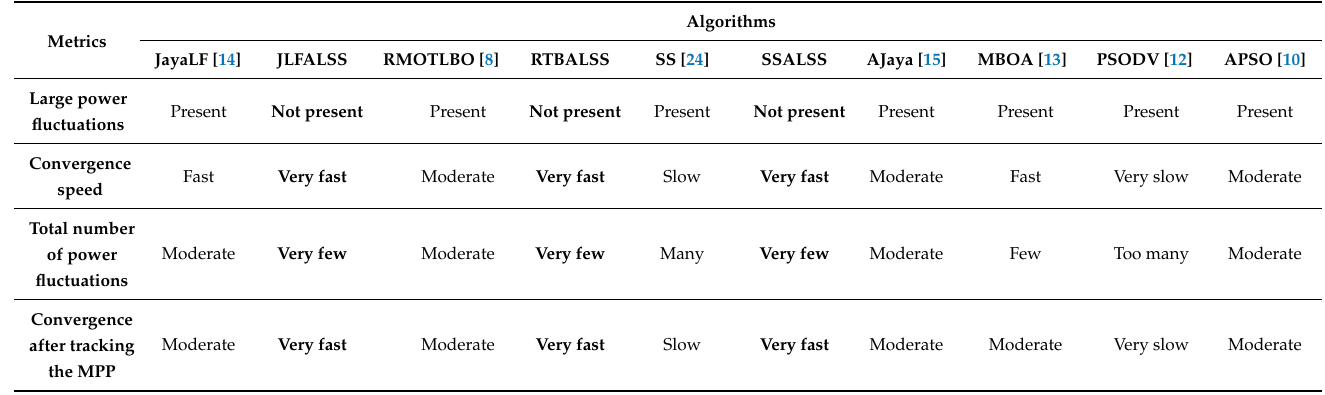
Table 7. Qualitative comparison between the proposed and other algorithms in the